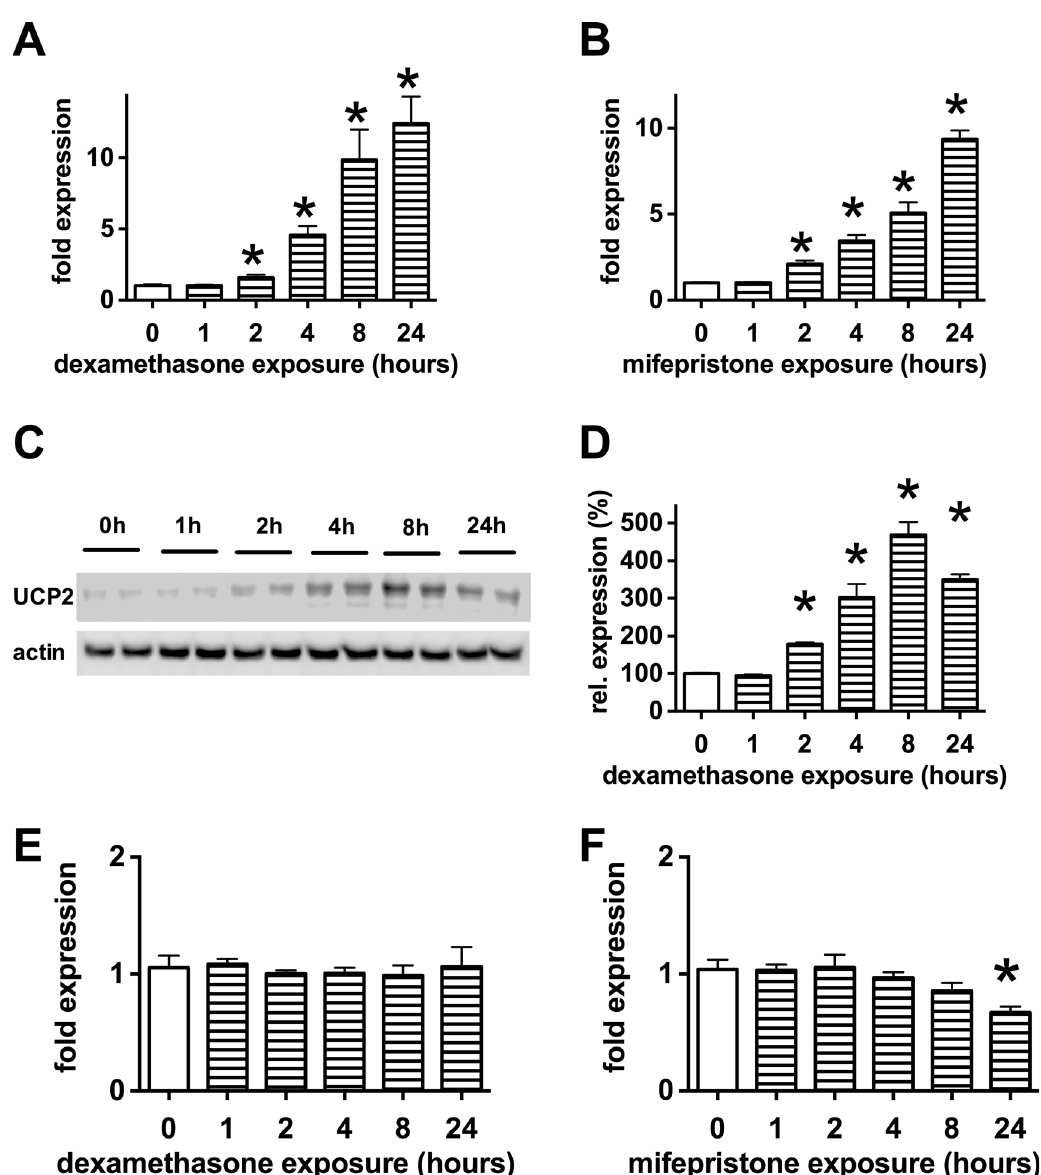
Fig 5. Time course of steroid induced UCP2 expression. A-D: Confluent b.End3 endothelial cells were exposed to A, C, D : dexamethasone (1 μ M) or B: mifepristone (3 μ M) for the indicated time period. A, B : UCP2 mRNA expression was measured by UCP2 Taqman assay using rRNA normalization. C, D : UCP2 protein expression was measured by Western blotting. Representative blot image ( C ) and densitometry results ( D ) are shown. E, F: HepG2 human liver cells were treated with dexamethasone (1 μ M, E ) or mifepristone (3 μ M, F ) for the indicated time periods and UCP2 expression was determined by Taqman assay. ( * p < 0.05 glucocorticoid treatment induced significant changes in the UCP2